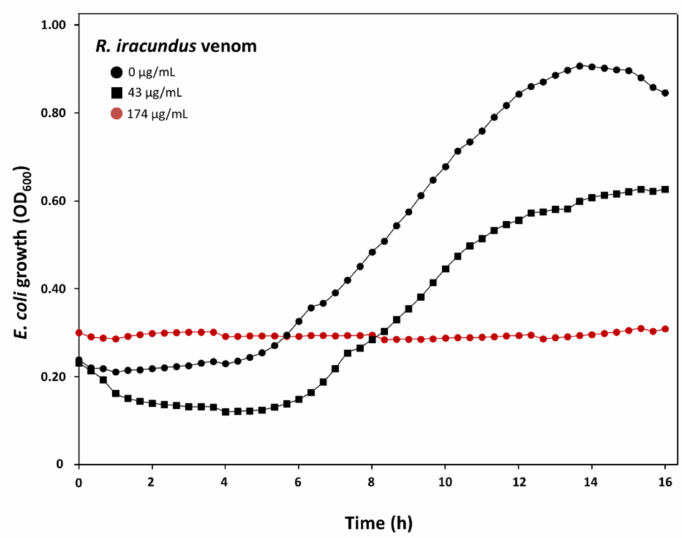
Figure 4. Effect of assassin bug Rhynocoris iracundus venom on E. coli D31 growth. Venom activity was tested using different concentrations of crude venom incubated together with E. coli D31. Bacterial growth was monitored by measuring OD 600 values at 20 min intervals for 16 h. The effective venom concentration of 174 µ g/mL is shown as a red line, and the bacterial growth curve at lower venom concentrations (43 µ g/mL), or without venom (0 µ g/mL), are displayed as black